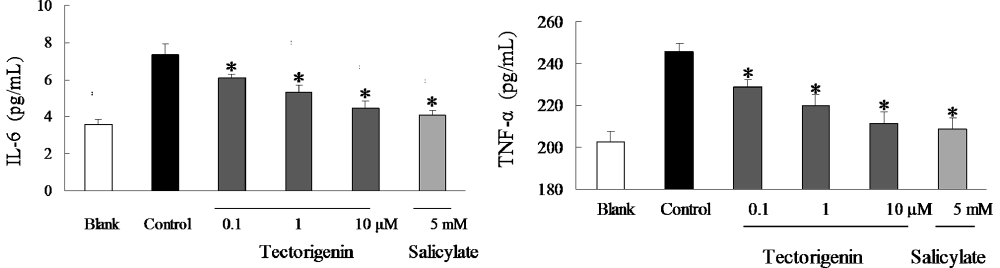
Figure 4. Tectorigenin inhibited IL-6 and TNF- a production in PA- stimulated HUVECs. HUVECs were pretreated with tectorigenin, salicylate for 30 min, and then incubated with PA (100 m M) for 12 h. The concentrations of TNF- a and IL-6 in the conditioned medium were measured with ELISA Kits. Salicylate was taken as positive control. The blank group was treated with an equal amount of the vehicle (medium containing 0.1% DMSO and 10% BSA). The results were expressed as the mean 6 SD ( n =3). * p , 0.05 vs control group.